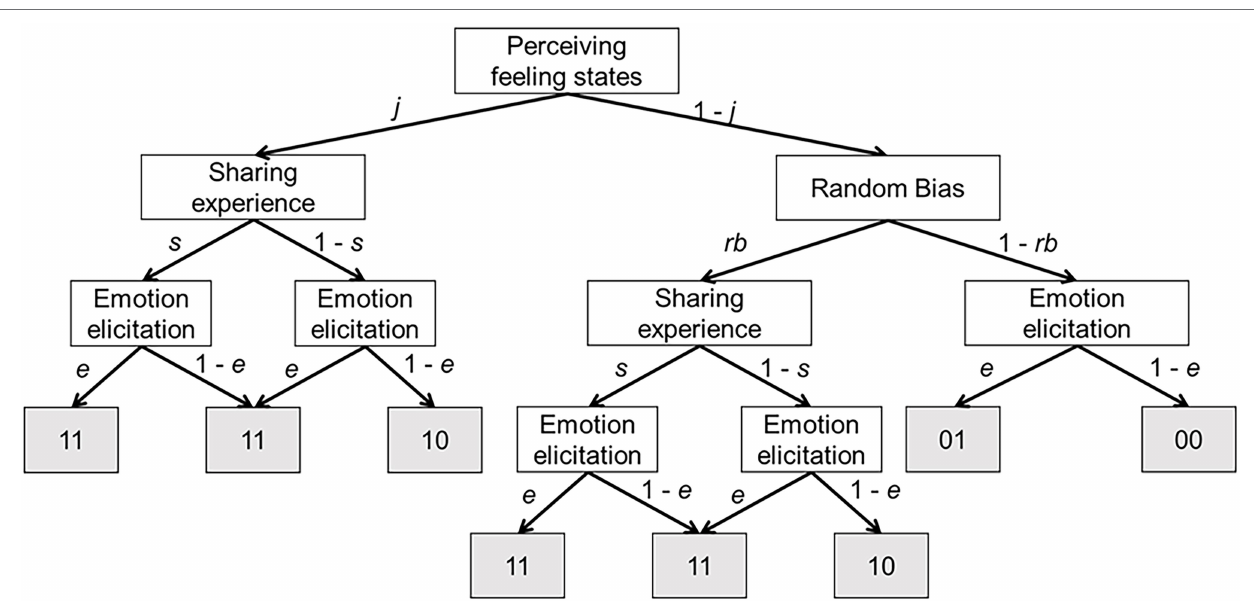
FIGURE 1 | Schematic representation of the model used for this study. White squares represent the latent states; and gray squares represent the observed variables. The first number of gray colored observation means “detecting an emotional experience from perceived emotional facial expressions (1) or not (0),” whereas the second number means “the same emotional experience for the emotional expression occurred in the perceiver (1) or not (0).” Consequently, the gray square containing “01” represents the following observed variable: “the experience was not detected from the emotional expression (0), but the same emotional experience occurred (1).” In a hierarchical model, each participant has its own parameters.